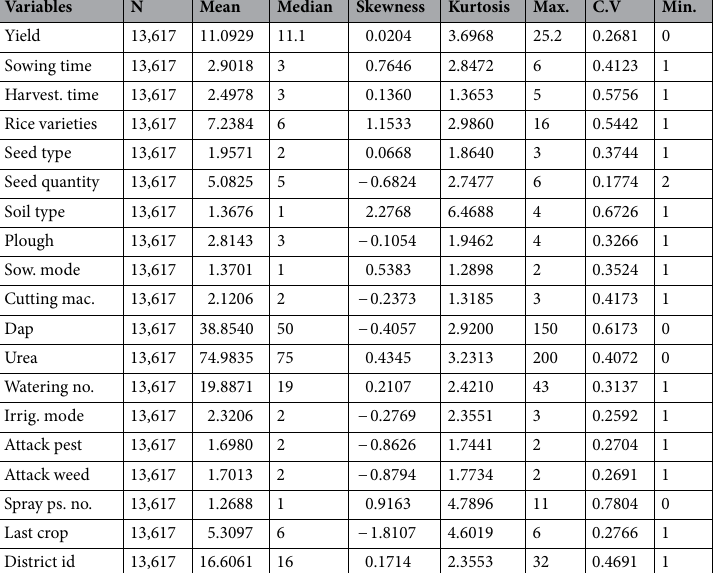
Table 1. Summary statistics of rice variables. N number of observations, Mean arithmetic mean, Max maximum, Min minimum, CV coefficient of